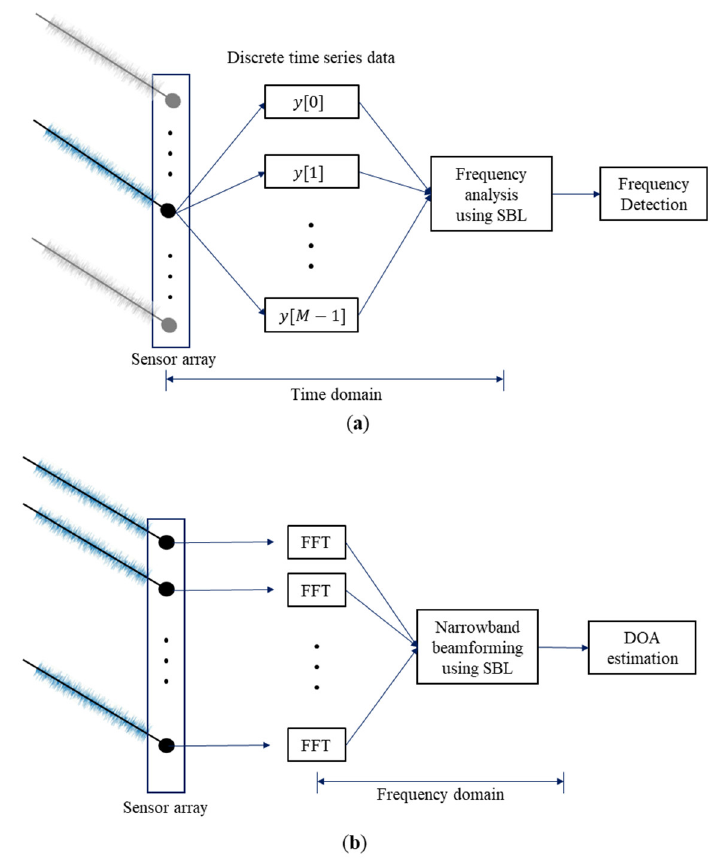
Figure 3. Process of ( a ) the frequency analysis using single measurement; ( b ) the DOA estimation using single measurement.